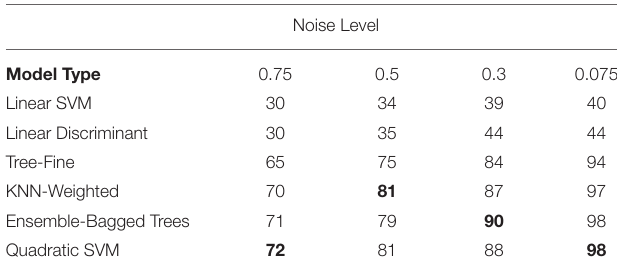
TABLE 1 | Classification accuracy for a subset of tested classifiers for a range of noise levels (chance is